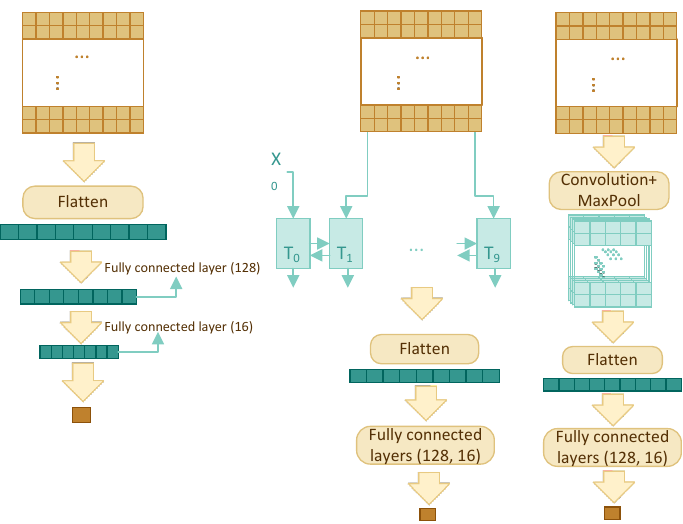
Figure 2. The MLP, RNN, CNN architectures (from left to right).